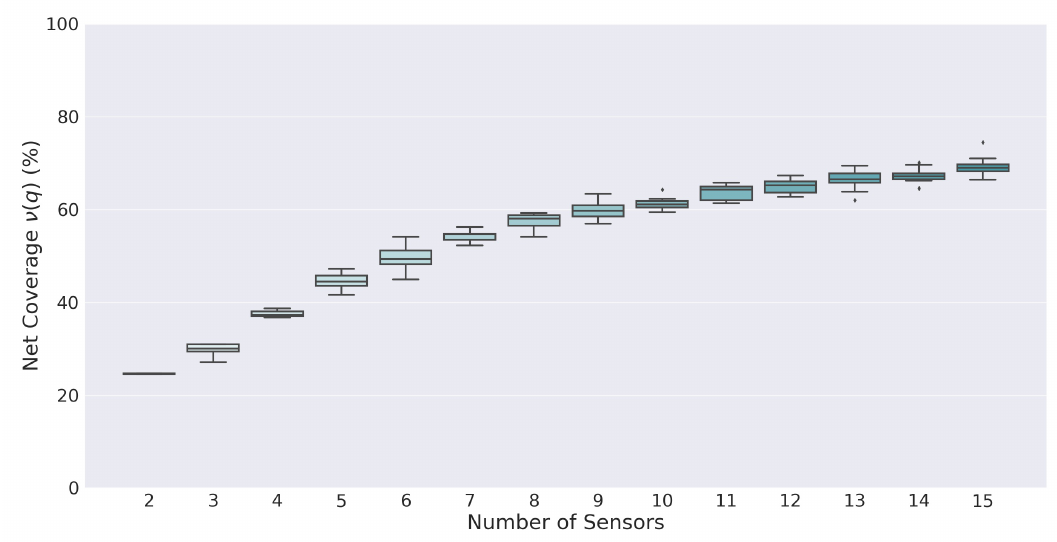
Figure 7. Result of the OSP calculation